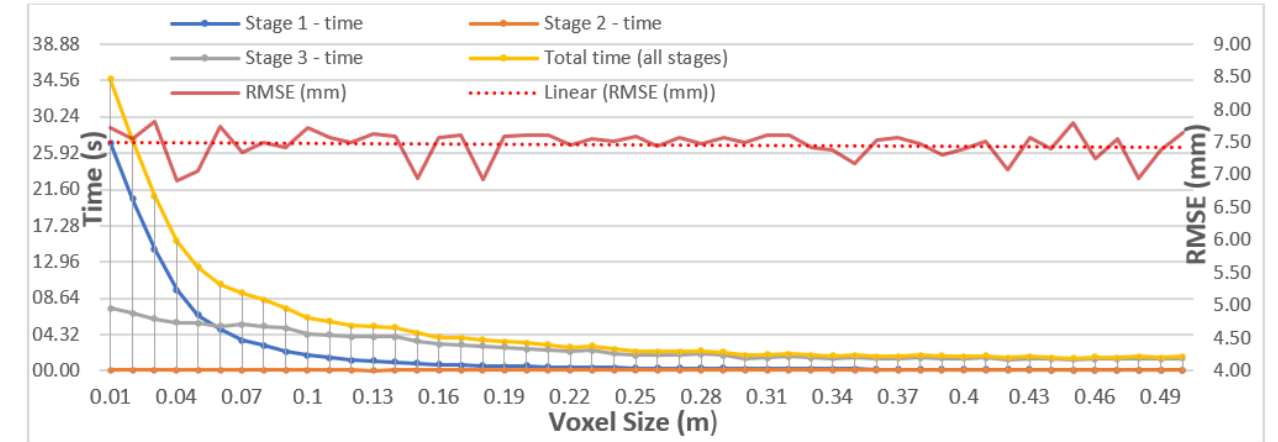
Figure 14. Graph indicating the processing time and RMSE at different voxel sizes ranging from 0.01 to 0.5 m for dataset 1.